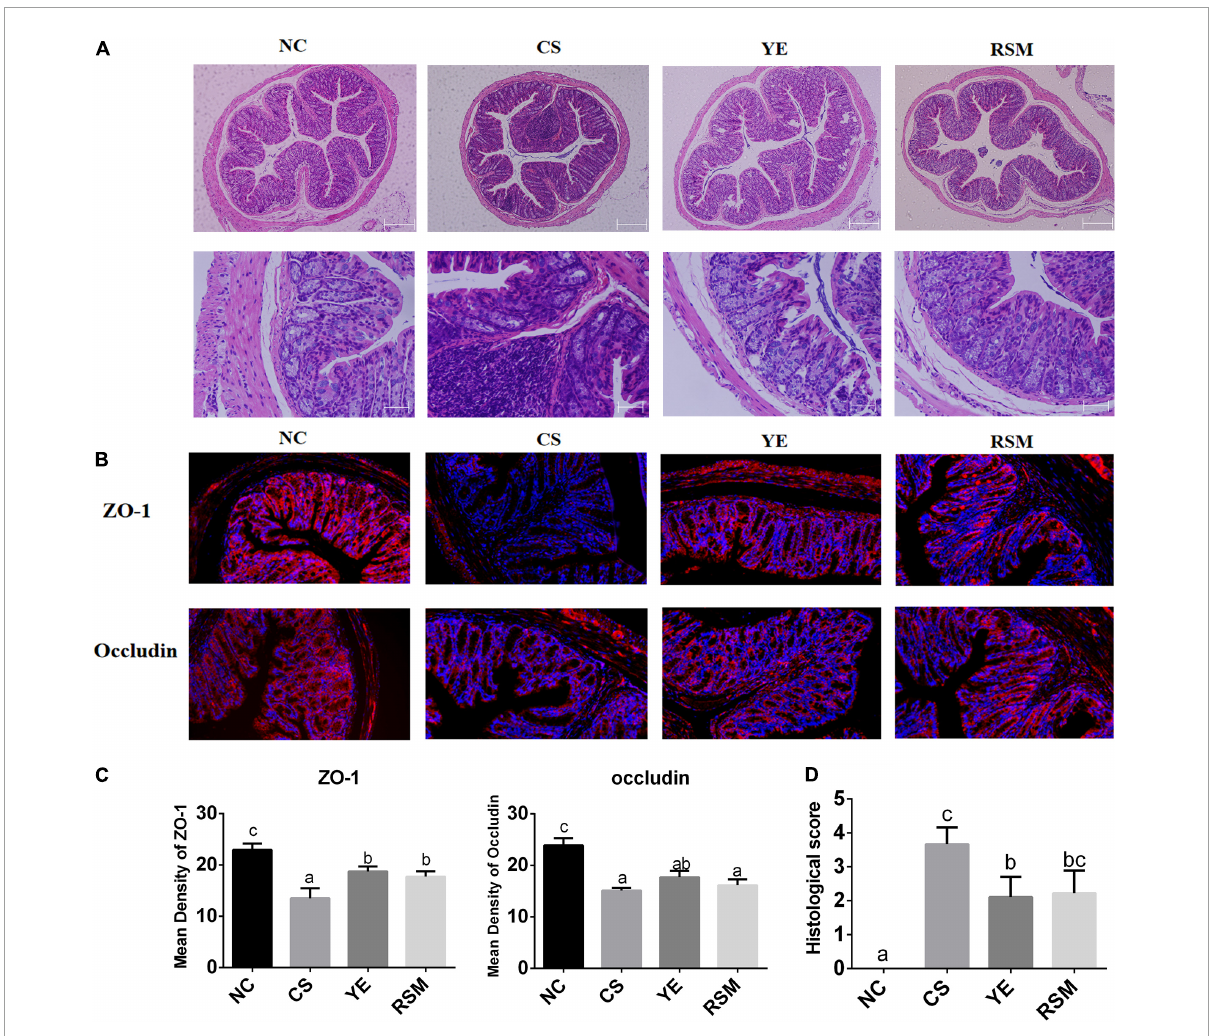
FIGURE3 Effects of two algal oils on intestinal barrier damage caused by CS. (A) H&E staining of representative colons from untreated mice or mice treated with CS and algal oil are shown using the same microscope (magnification of 100 × , 400 × ). (B) Representative immunofluorescence staining of the tight junction proteins in the colon tissue (200 × ). (C) The mean density of the tight junction proteins (ZO-1, Occludin). (D) Histological score. Data ( n = 9 per group) are expressed as mean ± SEM; groups with different letters statistically differ. Groups with the same letter are considered to have no significant differences, groups with different letters are significantly different from each other ( P <